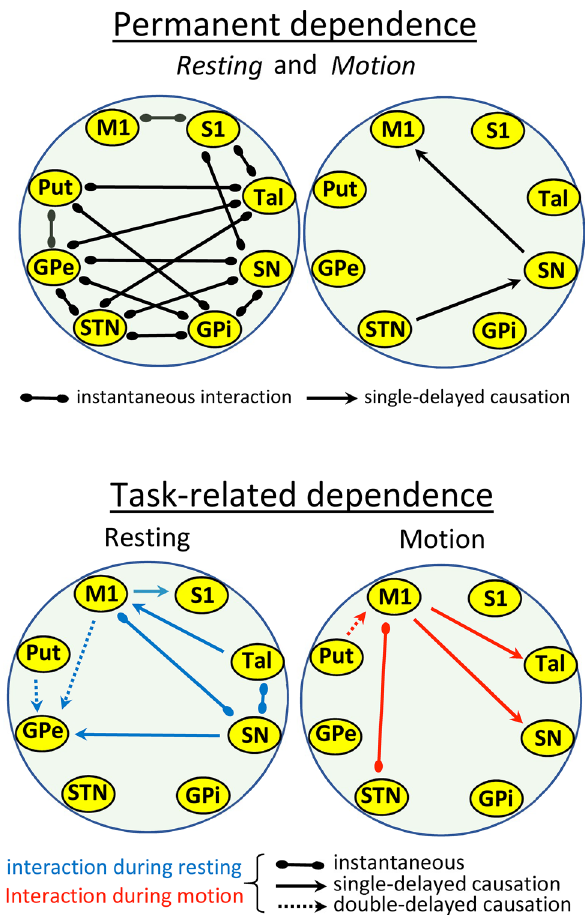
Figure 2. Permanent (resting + motion tasks) and task-dependent interactions. Connections between centers show relationships with statistical value ( p < 0.01). M1: primary motor cortex, S1: primary somato-sensory cortex, Put: putamen, GPe: external globus pallidum, STN: subthalamic nucleus, GPi: internal globus pallidum, SN: substantia nigra, Tal: motor